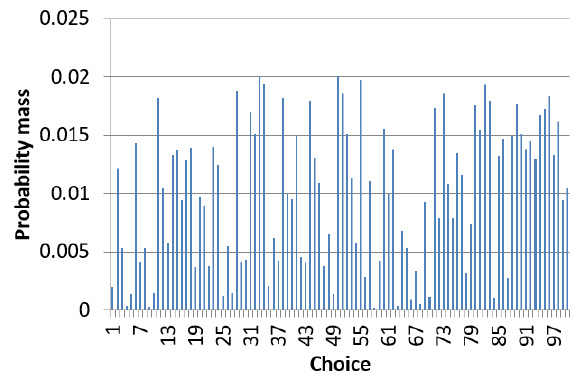
Figure 3. Example distribution where compressing with k = 2 produces significantly lower error than k = 10. The full distribution has mean 54.188, while the k = 2 compression has mean 0.548 (54.253 after normalization) and the k = 10 compression has mean 5.009 (55.009 after normalization). The normalized errors between the means were 0.906 for k = 10 and 0.048 for k = 2, yielding a difference of 0.859 in favor of k = 2.